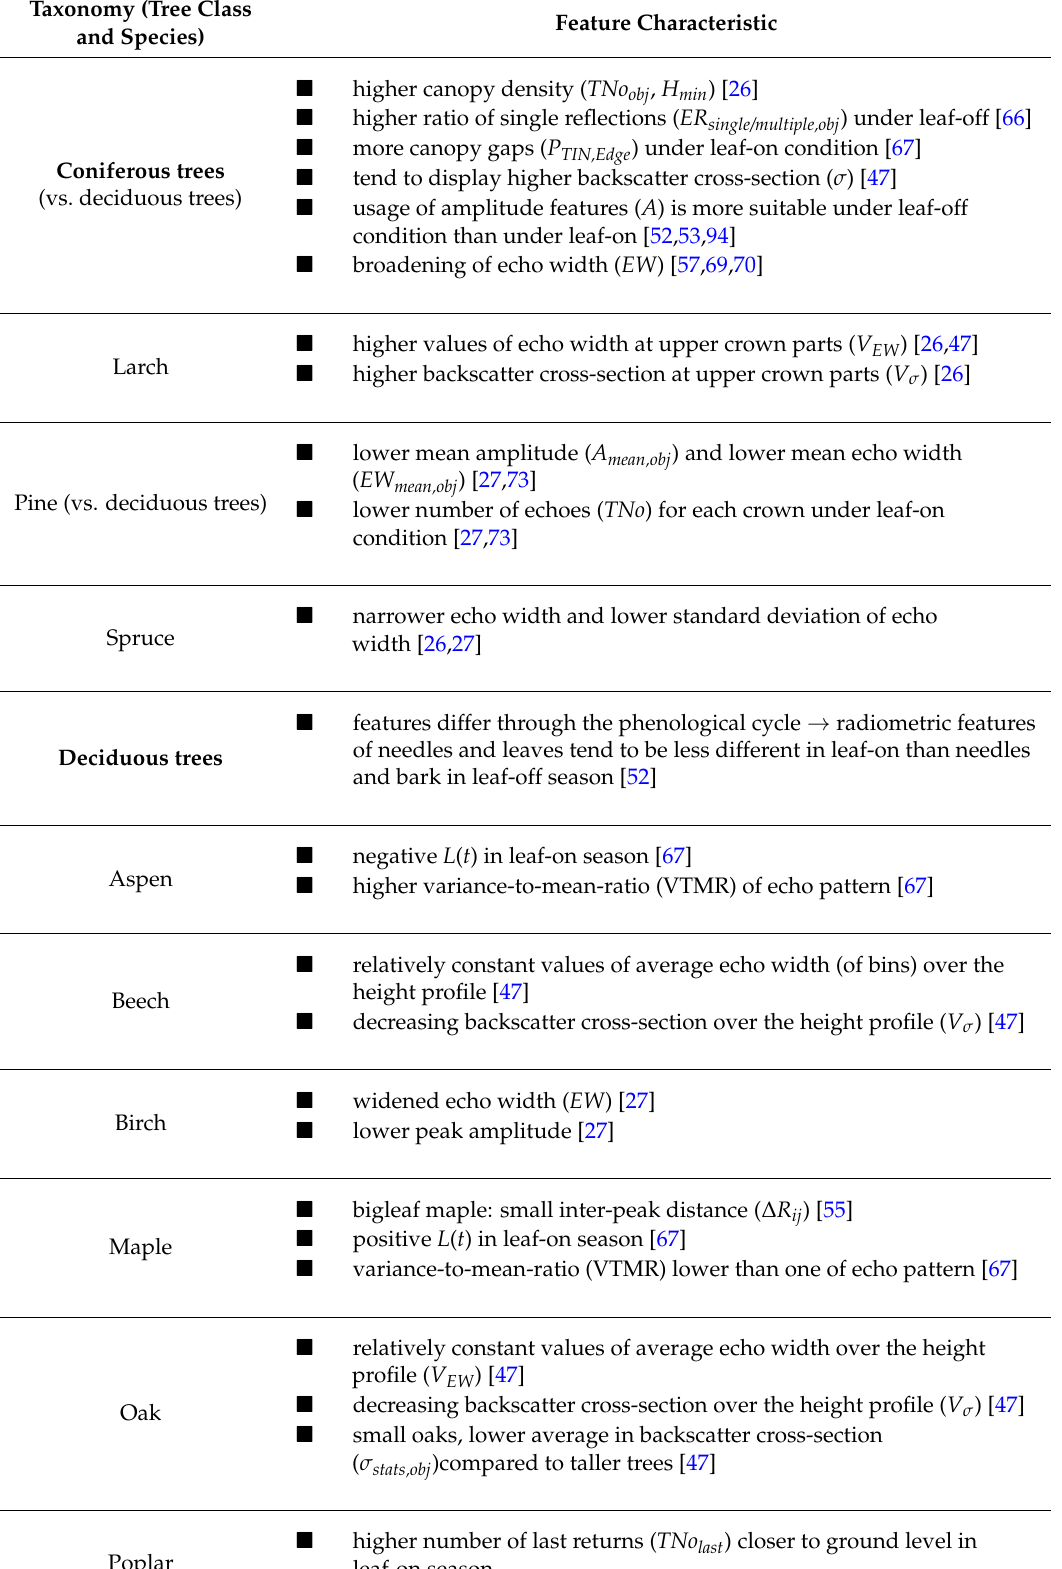
Table 3. Summary of species-specific feature characteristics of the major tree species. Taxonomy (Tree